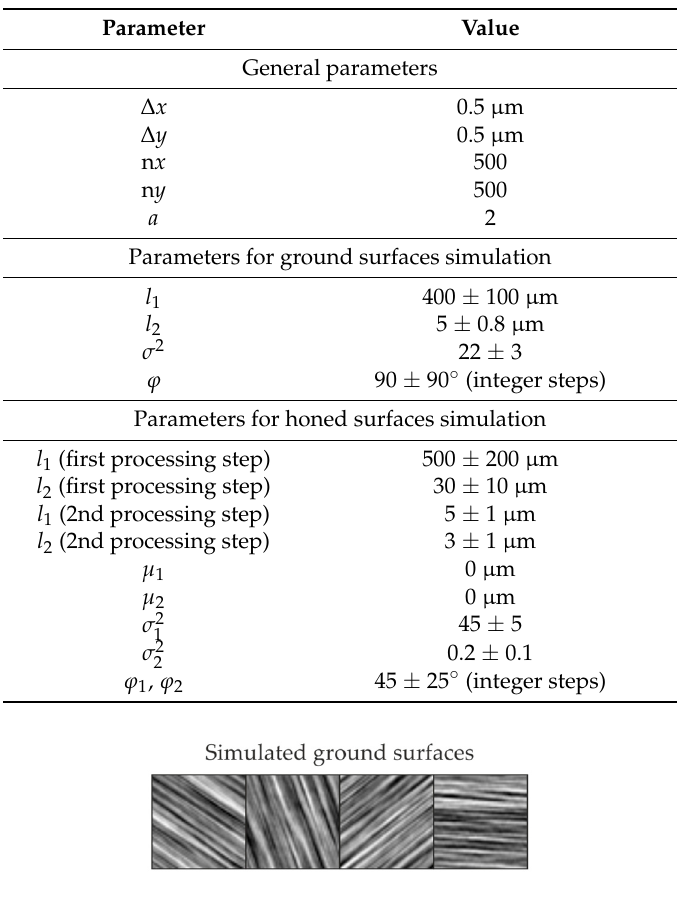
Table 1. Selected parameters for generating the training and test data. For parameters with a range, a uniform distribution over the range is assumed.